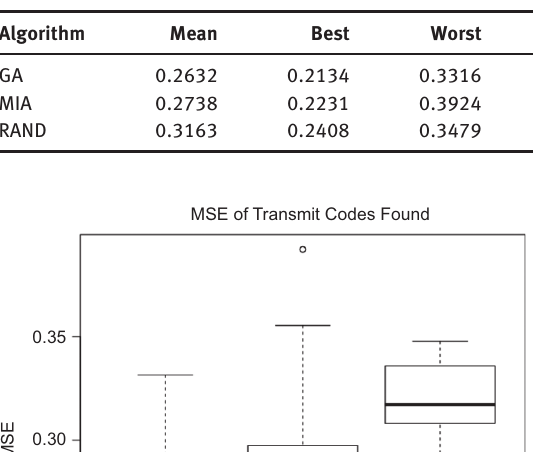
Table 3. Length 52 2 PSK